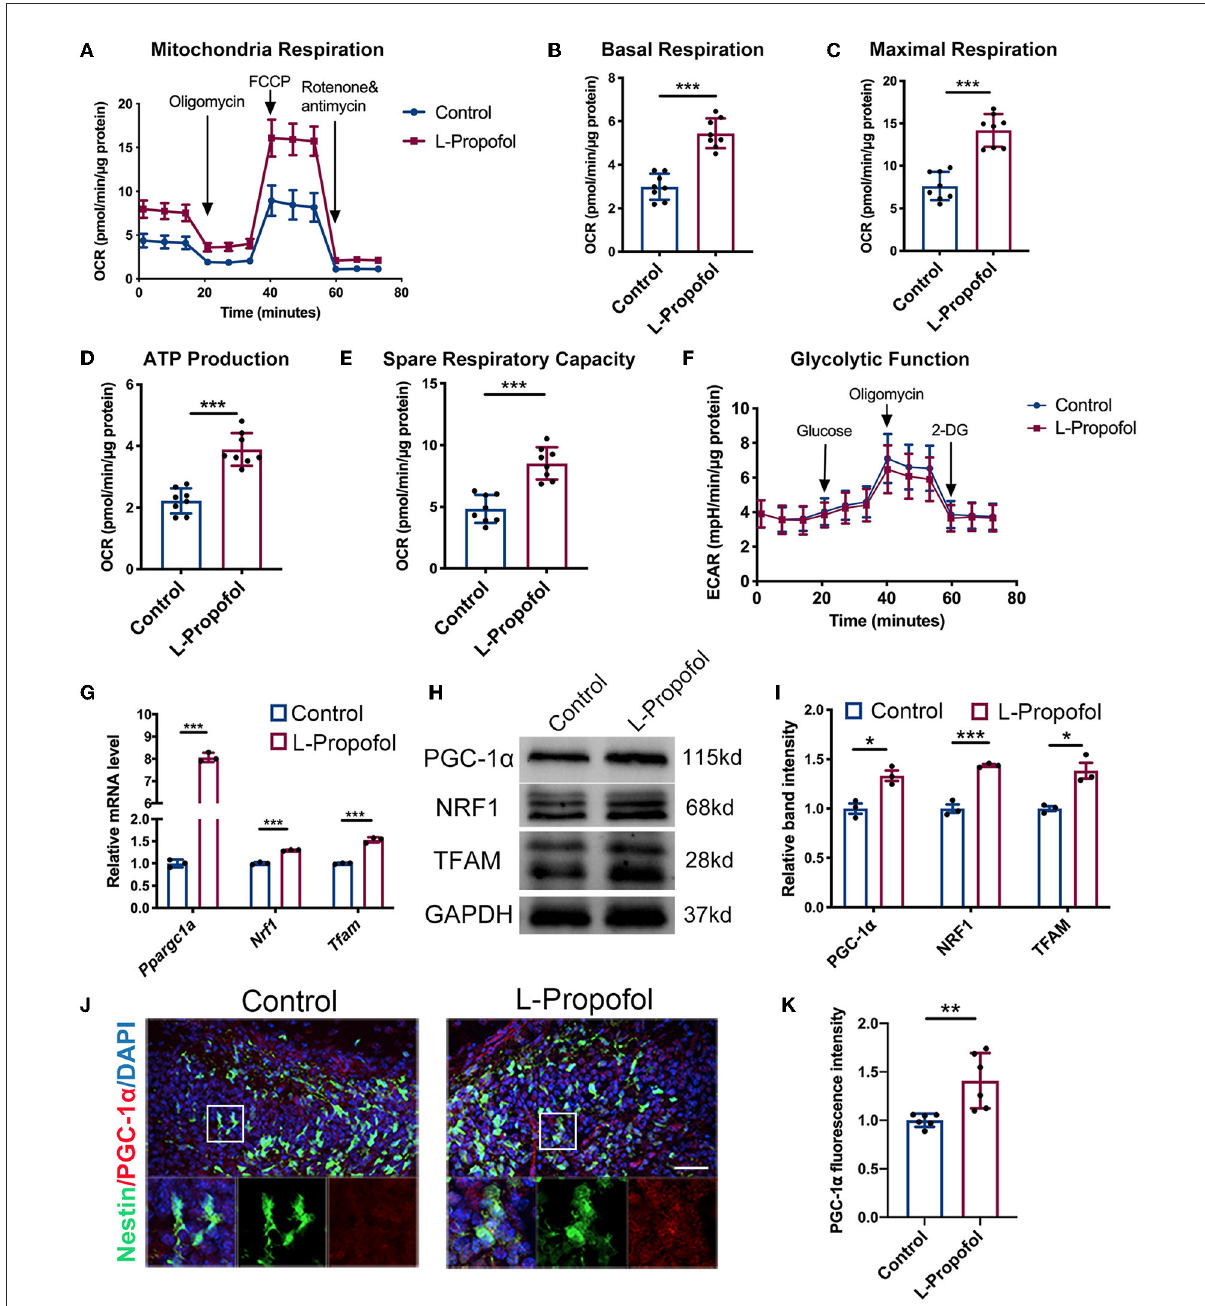
FIGURE5 Metabolic shift and activated PGC-1 α /NRF1/TFAM pathway in NSCs were confirmed after Propofol treatment. (A–E) Low-dose Propofol enhanced OXPHOS level in primary NSCs measured by the (A) oxygen consumption rate (OCR) normalized by protein content ( µ g) including OXPHOS parameters (B) basal respiration ( p < 0.001), (C) maximal respiration ( p < 0.001), (D ) ATP-linked respiration ( p < 0.001), and (E) spare respiratory capacity ( p < 0.001). N = 8. (F) Glycolytic function showed a similar result in normalized extracellular acidification rate (ECAR). N = 8. (G–I) Relative mRNA (G) (Ppargc1a: p < 0.001; Nrf1: p < 0.001; Tfam: p < 0.001) and protein (H,I) levels (PGC-1 α : p = 0.010; NRF1: p < 0.001; TFAM: p = 0.011) showing activated mitochondrial biogenesis mediated by PGC-1 α /NRF1/TFAM pathway after low-dose Propofol treatment. N = 3. (J,K) Confocal images of PGC-1 α (red) staining (J) and quantification (K) showing an increased intensity of PGC-1 α in NSCs in the DG of Nestin-GFP mice 6h after low-dose Propofol administration at PND 7 in L-Propofol group ( p = 0.007). N = 6. Scale bar, 40 µ m. * p < 0.05; ** p < 0.01; *** p < 0.001. Error bars, mean ± SD. The Student’s t -test was used for